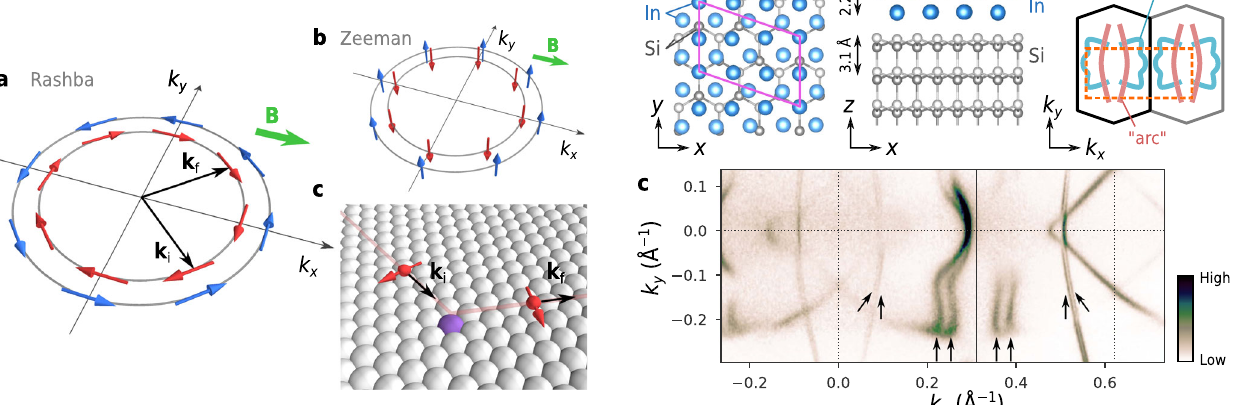
Fig. 1 Schematic illustration of dynamic spin-momentum locking. a Fermi surfaces in the presence of Rashba-type SOC. The spins are polarised in the in-plane directions and locked to the momentum. The split Fermi surfaces are characterised by spin textures with opposite helicities. b Fermi surfaces in the presence of Zeeman-type SOC. The spins are oriented in the out-of- plane directions. The green arrows in ( a ) and ( b ) indicate a magnetic fi eld applied in the in-plane direction. c When an electron at the initial state k i is elastically scattered to k f by a non-magnetic scattering centre (depicted by a purple ball), its spin is forced to rotate.